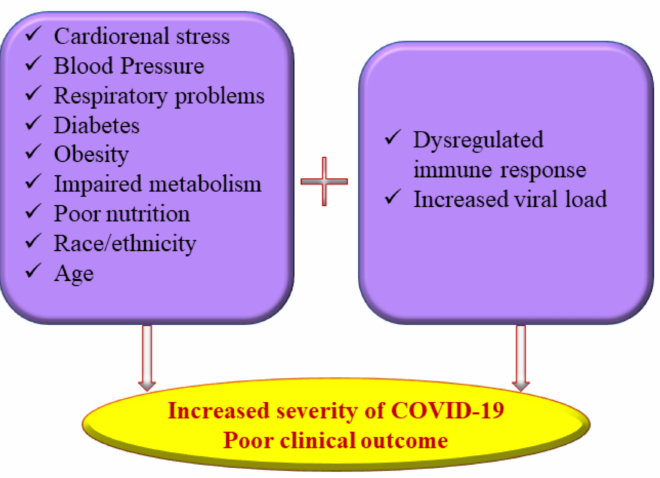
Figure 1. Multiple risk factors of severe coronavirus disease 2019 (COVID-19)